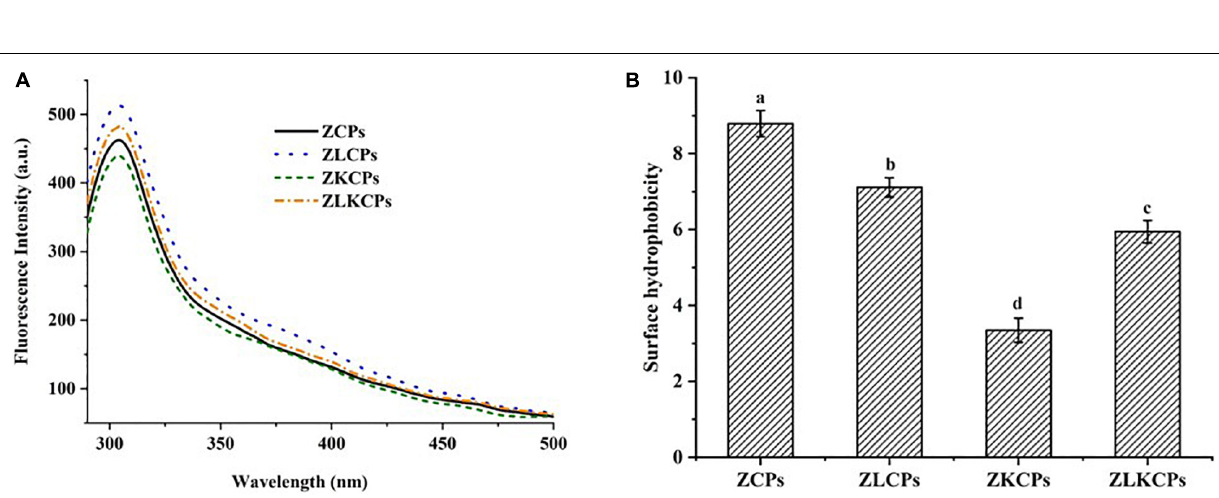
FIGURE 4 | Fourier transform infrared spectroscopy spectra (A) , circular dichroism (CD) spectroscopy spectra (B) , and the content of secondary structure (C) .